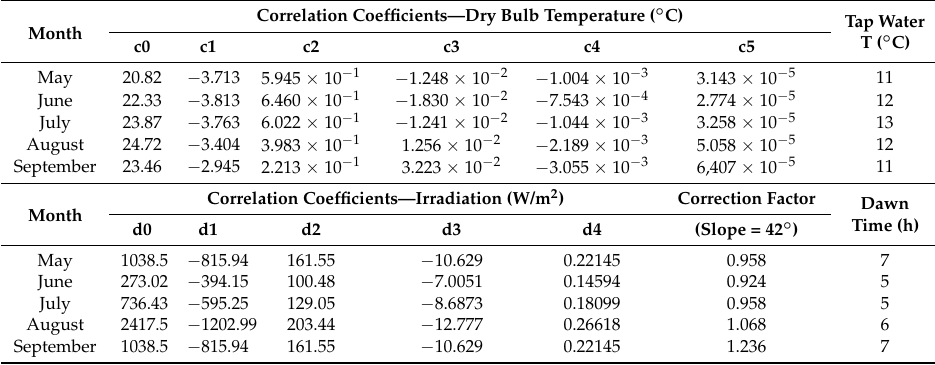
Table 3. Climatic data for Valladolid (typical days of summer months, from TMY data). Correlation Coefficients—Dry Bulb Temperature ( ◦ C) Month